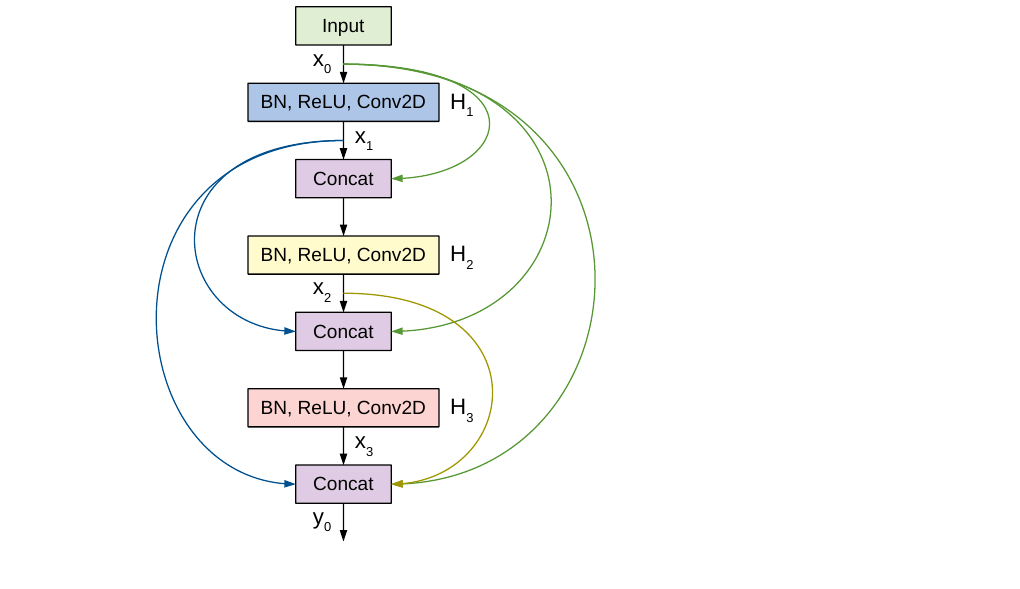
Figure 6. A 3-layer Dense block in DenseNet. The input to each layer is all the previous feature maps. Table 1 summarizes the important characteristics of the adopted deep CNN models.